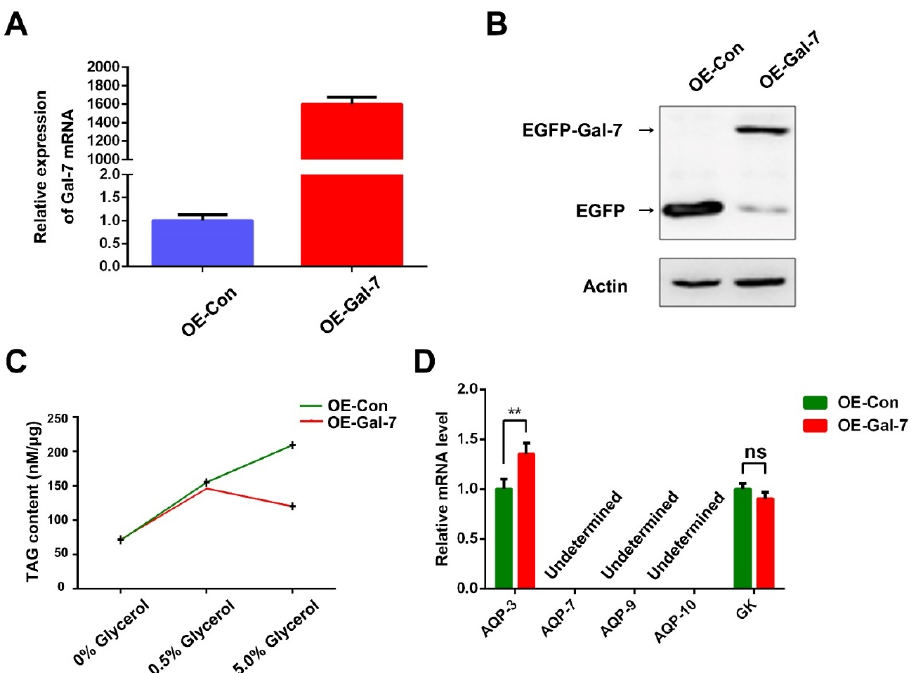
Figure 6. Overexpression of Gal-7 decreased the intracellular TAG levels but increased the mRNA expression of AQP-3 in HeLa cells. ( A ) mRNA expression of Gal-7 in HeLa by qRT-PCR. The Ct value of the Gal-7 gene was normalized to that of β -actin. Relative expression level was computed using 2 −ΔΔ Ct method. The data are represented as mean ± S.D. from three independent experiments. ( B ) Protein expression of Gal-7 in HeLa by Western blot. The level of β -actin was used as a control for equal amounts of input protein. Three independent experiments were performed, and one representative blot is shown. ( C ) The cellular TAG concentration was quantified by employing a TAG detection kit. Bars represent the mean ± SEM of three independent experiments. ( D ) The expression of AQP-3, AQP-7, AQP-9, AQP-10 and GK were assessed at 6 h after the stimulation with 5.0% glycerol. The Ct value of the target genes was normalized to that of β -actin. Relative expression level was computed using 2 − ∆∆ Ct method. Bars represent the mean ± SEM of three independent experiments. ** p <